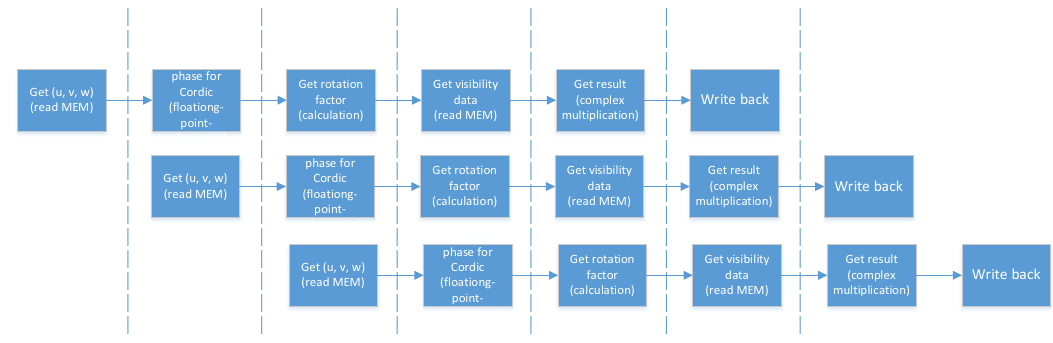
Figure 7. The pipeline of the phase rotation acceleration system.